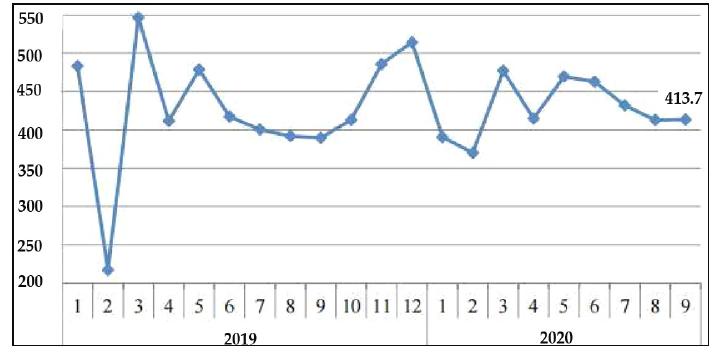
Figure 4. Weight of goods transported by railway (thousand tons) (Vietnam Logistics Report, 2020).